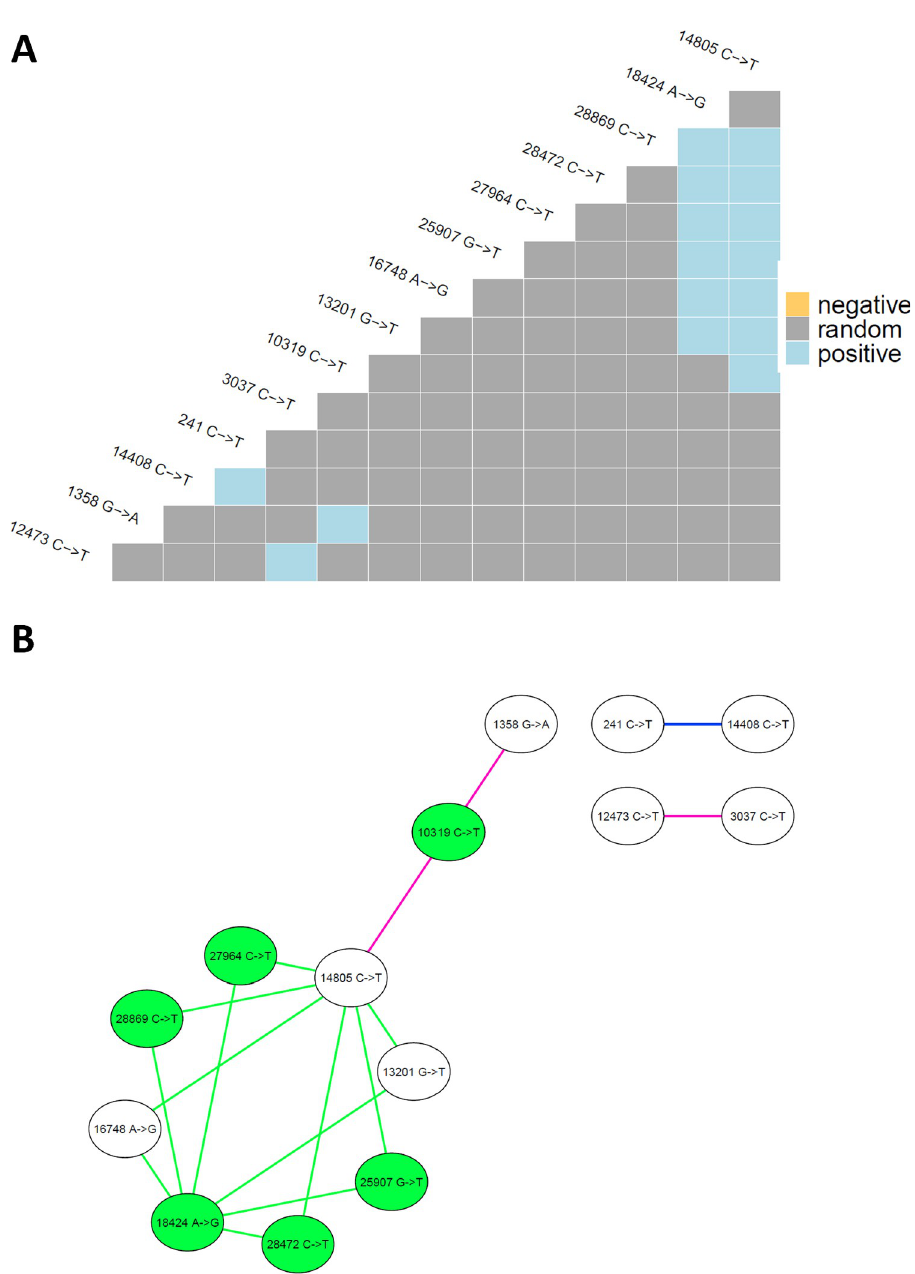
Fig 6. Co-occurrence and network analysis of mutations detected in WWTP influent and university samples. (A) Co-occurrence of mutations. No negative co-occurrences (those mutations detected together less often than expected by chance) were identified. (B) Co-occurrence network for mutations from the SARS-CoV-2 reference genome (accession MN908947.3) detected in University of South Carolina wastewater and Columbia WWTP influent. Network was rendered in Cytoscape [31] using the yFiles circular layout algorithm. Edge colors signify the sample types and collection period where the co-occurrences were detected: Green = co-occurrence found in university wastewater samples from September 2020, blue = co-occurrence found in all wastewater sample types (WWTP influent from July/August 2020, and WWTP influent and university samples from September 2020), pink = co-occurrence found in WWTP influent from September 2020 and university samples. Green nodes indicate signature mutations of clade 20G.